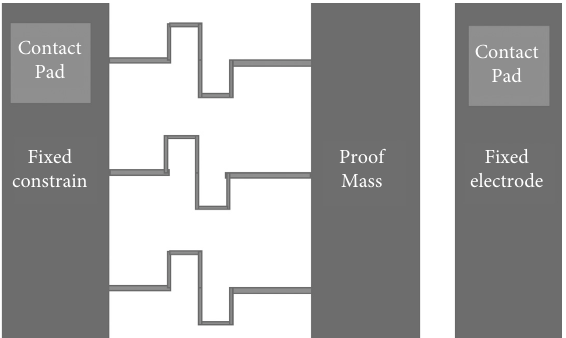
Figure 6: Proposed inertial sensor 6 with three sets of two semisquare